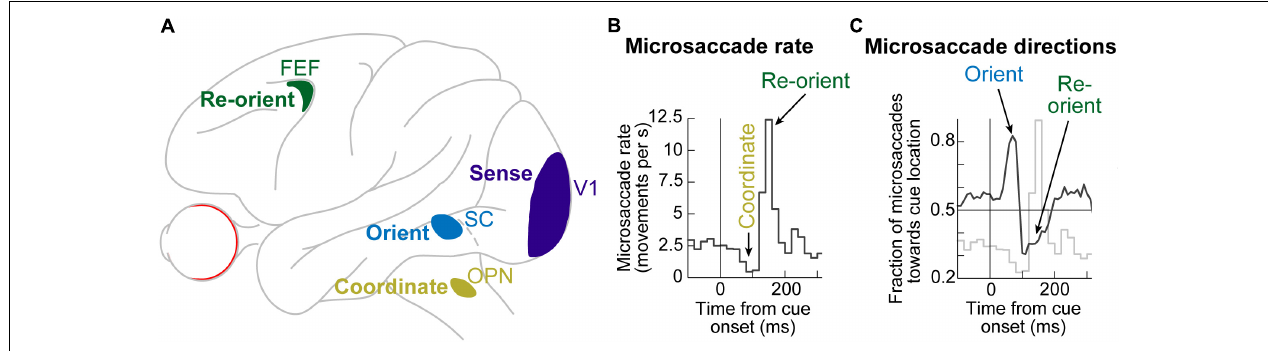
FIGURE 9 | An integrative view of the cortical and subcortical contributions to modulations of microsaccades after visual cues. (A) Cue onsets are essentially “sensed” by all shown areas. However, the visual bursts occurring in the different areas contribute differential roles. Visual bursts in V1 likely serve visual detection in general. However, those in the SC at very similar times influence microsaccade directions, and those in OPN’s (again at similar times) influence coordination of microsaccade timing to result in microsaccadic inhibition. Such early cue-induced visual bursts in all of these areas likely trump the influences of early visual bursts in FEF, because the FEF seems to be least critical for early cue-induced microsaccades ( Figure 6 ). Rather, FEF activity matters much more after the initial reflexive influences mediated subcortically. Thus, FEF activity serves to re-orient microsaccades after the initial cue-induced reflexes. (B) The integrative view in (A) allows explicitly interpreting the individual components of known modulations in microsaccades after cue onset (e.g., Figure 1 ). In terms of microsaccade rate, visual bursts in OPN’s allow coordination of microsaccade timing, resulting in microsaccadic inhibition. Subsequent microsaccades (during the post-inhibition rebound phase) are mediated by FEF re-orienting. (C) In terms of microsaccade direction oscillations, SC visual bursts after cue onset are read out in a way to influence microsaccade directions toward the appearing cues. Subsequent microsaccades are deliberate efforts to maintain the eye at the fixated target despite the peripherally appearing cue. Therefore, microsaccade direction oscillations reflect an initial reflexive orientation mediated by the SC followed by a deliberate re-orientation mediated by the FEF.